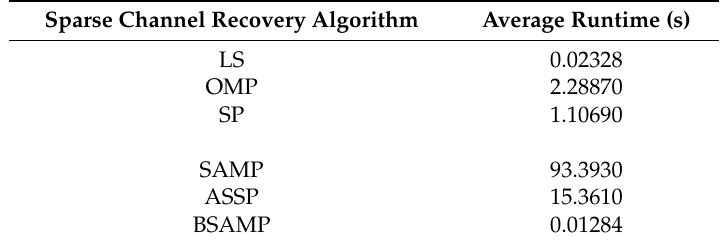
Table 2. Comparison of average running time of different sparse signal recovery algorithms. LS: least-square; OMP: orthogonal matching pursuit; SP: subspace pursuit; SAMP: sparsity adaptive matching pursuit; ASSP: adaptive and structured subspace pursuit; BSAMP: block sparsity adaptive matching pursuit.